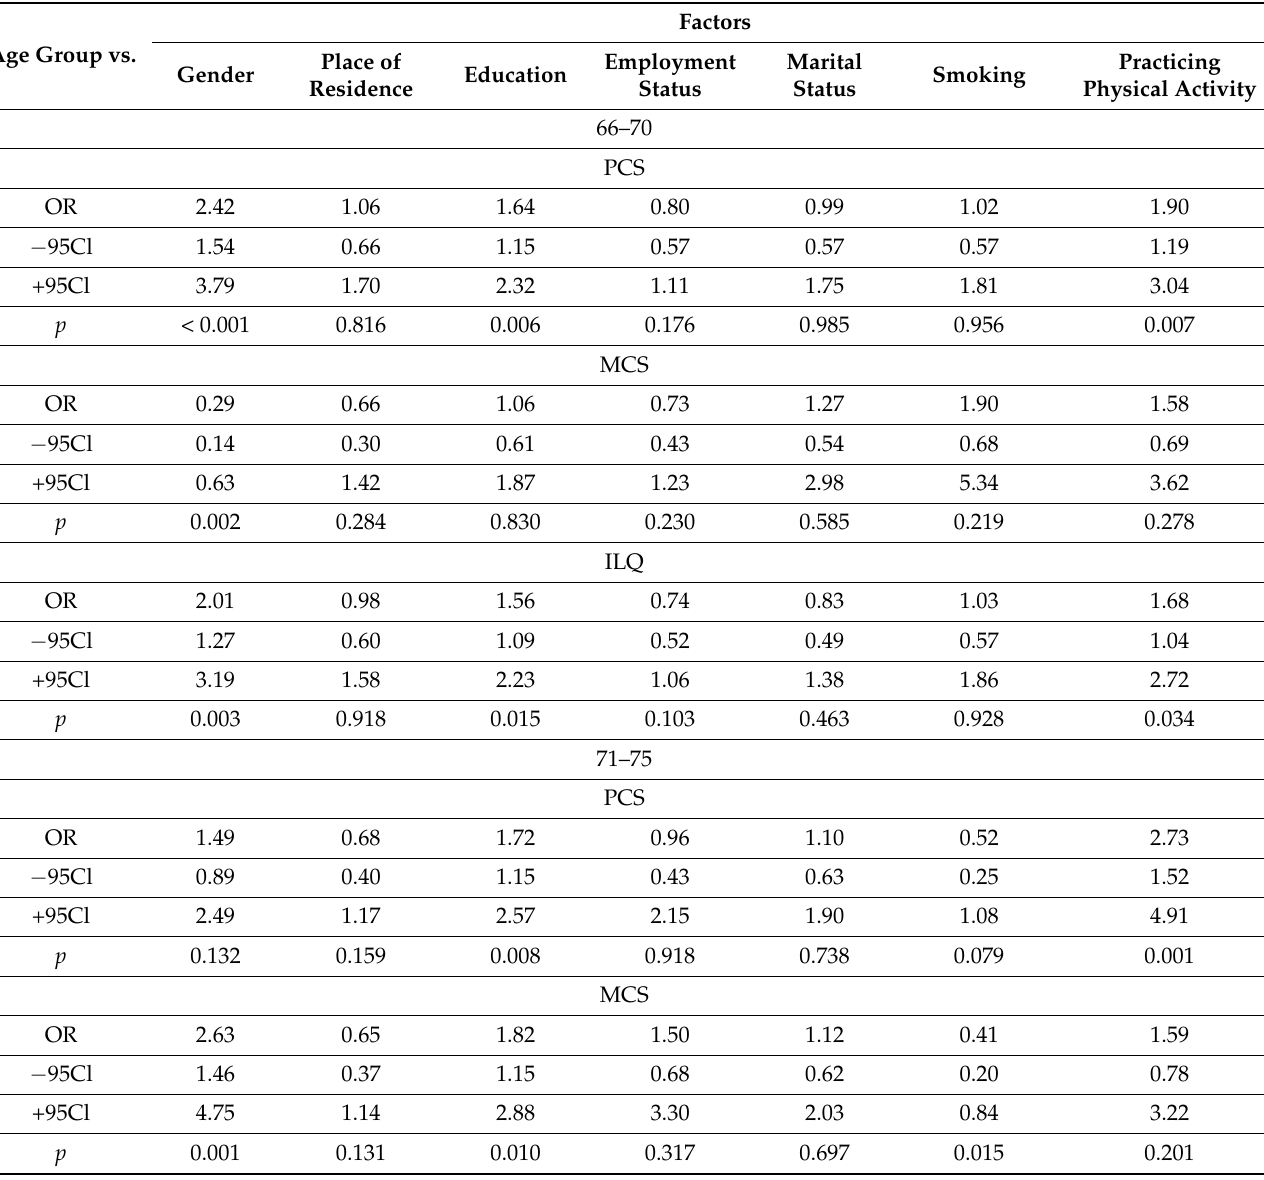
Table 7. The impact of the analyzed factors on the HRQoL (PCS, MCS, ILQ) in individual age groups and the chance of a higher HRQoL among the studied